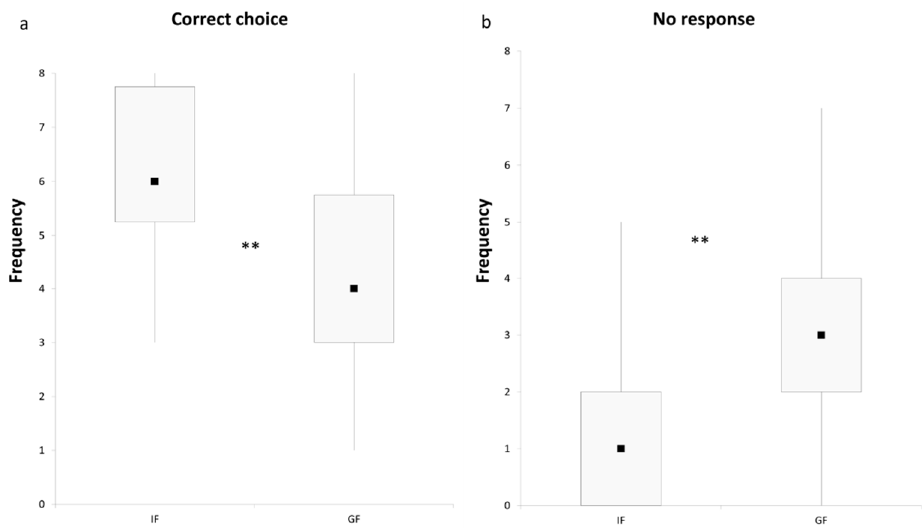
Figure 1. The frequency of correct choices ( a ) and no-choices ( b ) of intact (IF) and gonadectomized (GF) female dogs. Black squares: medians; boxes: quartiles; thin vertical lines: minimum and maximum values. ** p < 0.01.